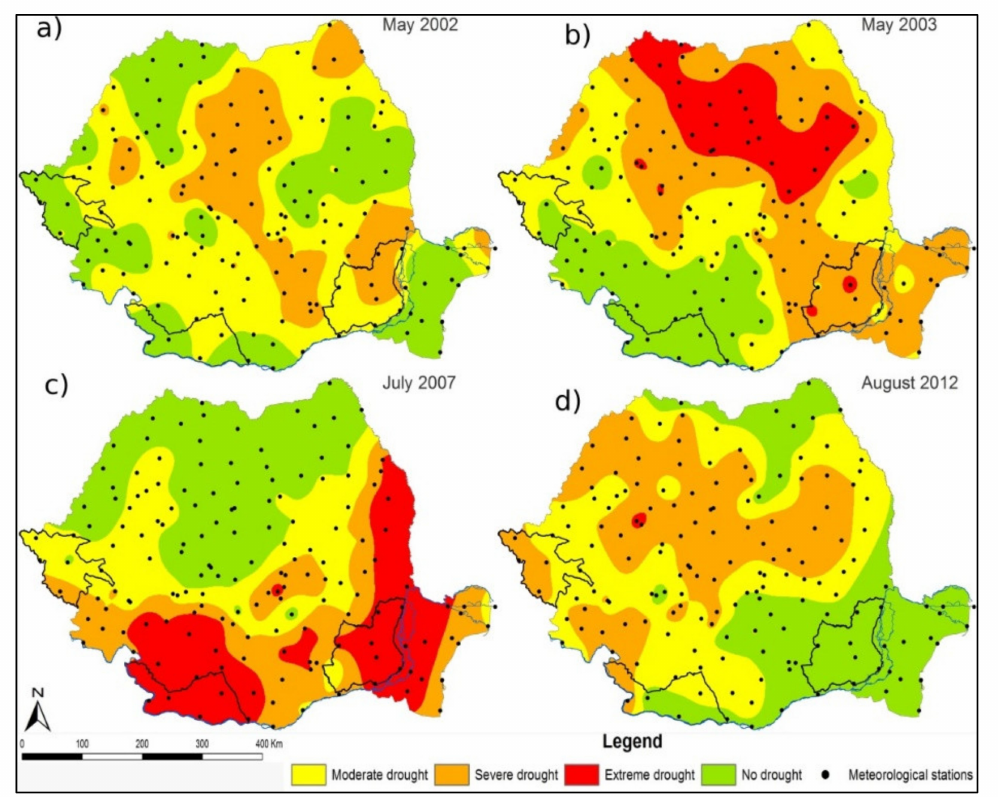
Figure 5. Standardized Precipitation Evapotranspiration Index in the agricultural areas of Romania in: ( a ) 2002; ( b ) 2003; ( c ) 2007; ( d )